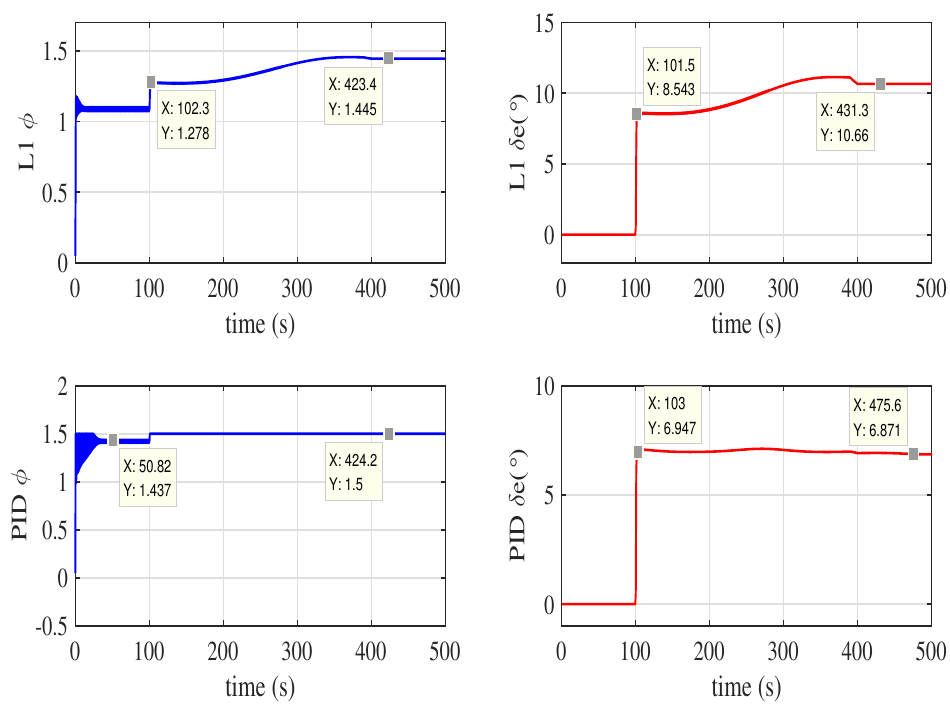
Figure 12. Comparison of control value proposed by PID and L 1 controller in pitching maneuver and fault state.